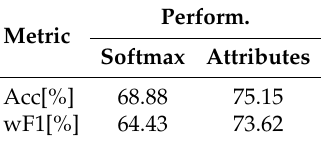
Table 10. The over-all accuracy [ % ] and weighted F1 [ % ] of HAR on the LARa OMoCap dataset.